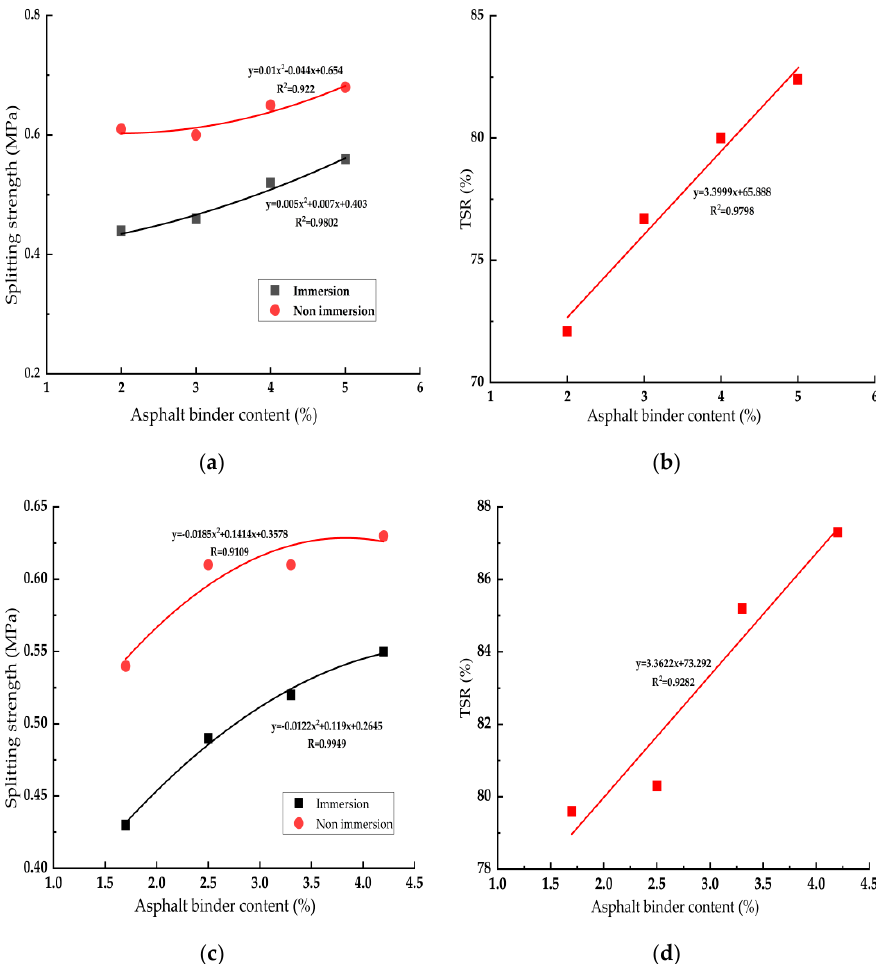
Figure 7. Freeze − thaw ITS test results of E/RAP and F/RAP. ( a ) Splitting strength of E/RAP with various asphalt binder contents. ( b ) TSR Freeze–thaw of E/RAP with various asphalt binder contents. ( c ) Splitting strength of F/RAP with various asphalt binder contents. ( d ) TSR Freeze–thaw of F/RAP with various asphalt binder